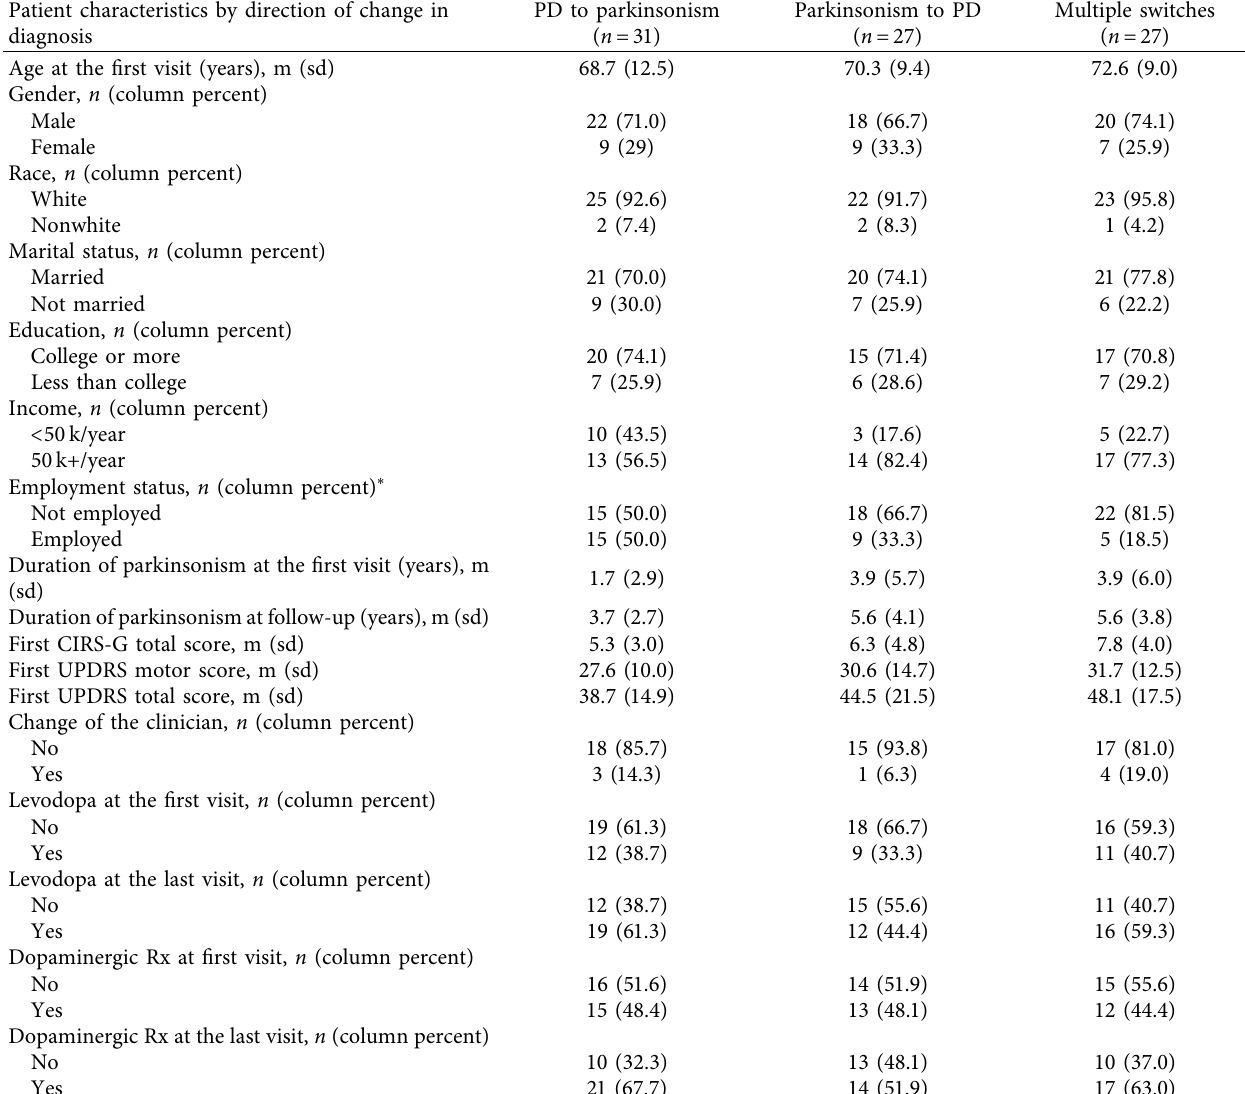
Table 2: Patient characteristics by direction of change in